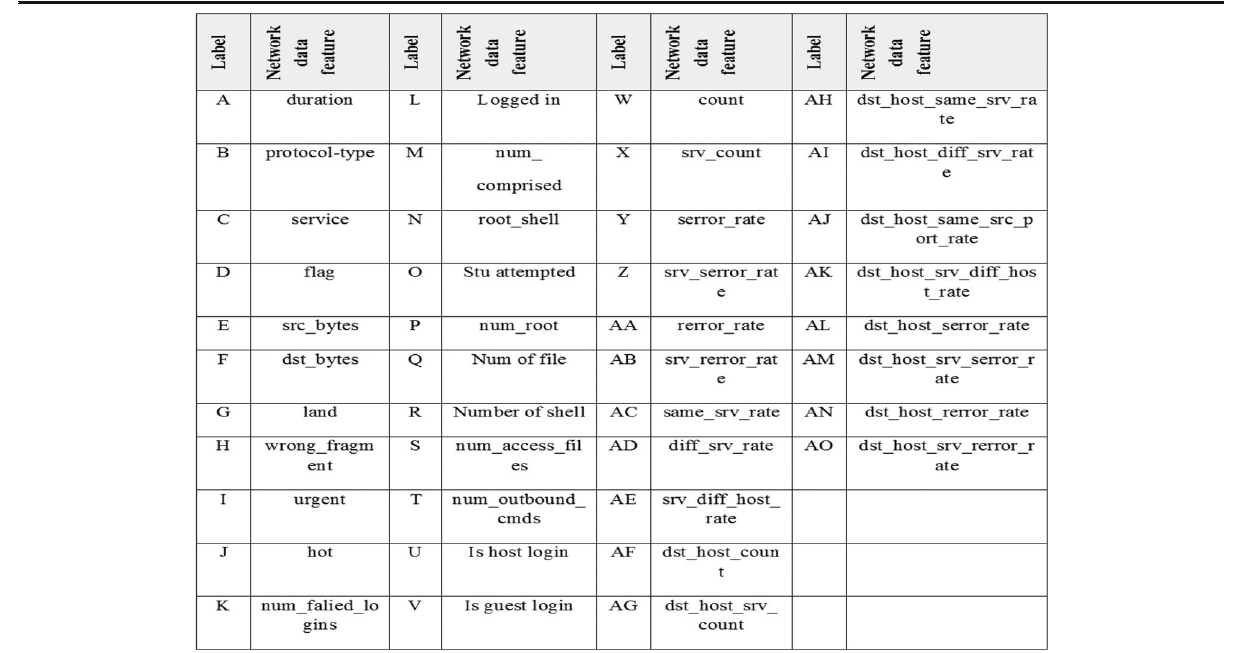
Table 7 The 41 features of KDD Cup99